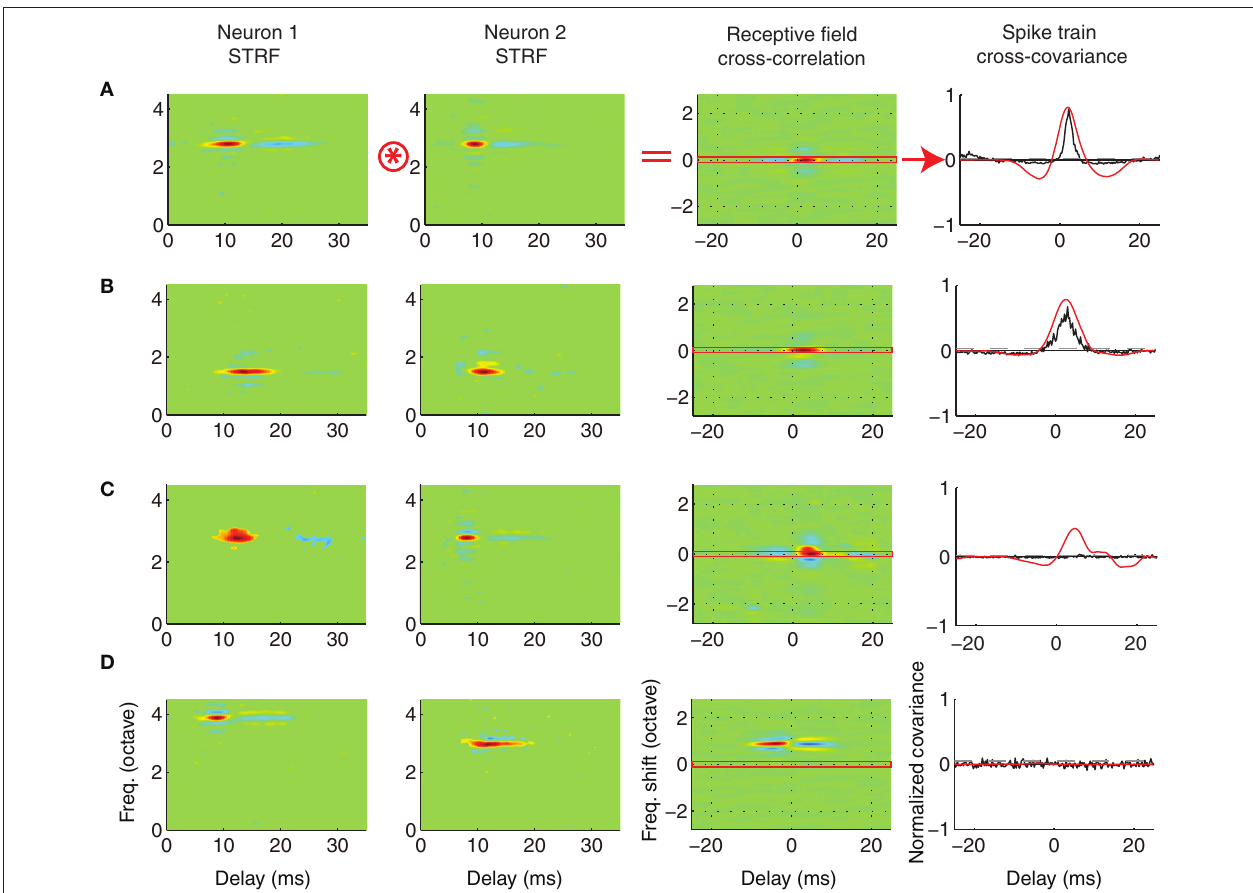
FIGURE 6 | Relationship between the receptive field and spike train crosscovariance of neighboring and distant neurons. The STRFs of four example neuron pairs are shown ( A–D , columns 1 and 2 ). The examples were chosen from the experimental ( A , ST; B , AT) and control groups ( C , DS; D , DSBF). For each pair, we computed the spike train crosscovariance function (SCC, normalized between -1 and 1, see Materials and Methods) to determine the strength and timing of the temporal correlations between the spike trains of neighboring neurons ( column 4, black) . We used the STRFs for each pair to predict the SCC. For each pair of neurons, this is done by performing a two-dimensional cross-correlation between the STRF of each neuron ( column 3) and